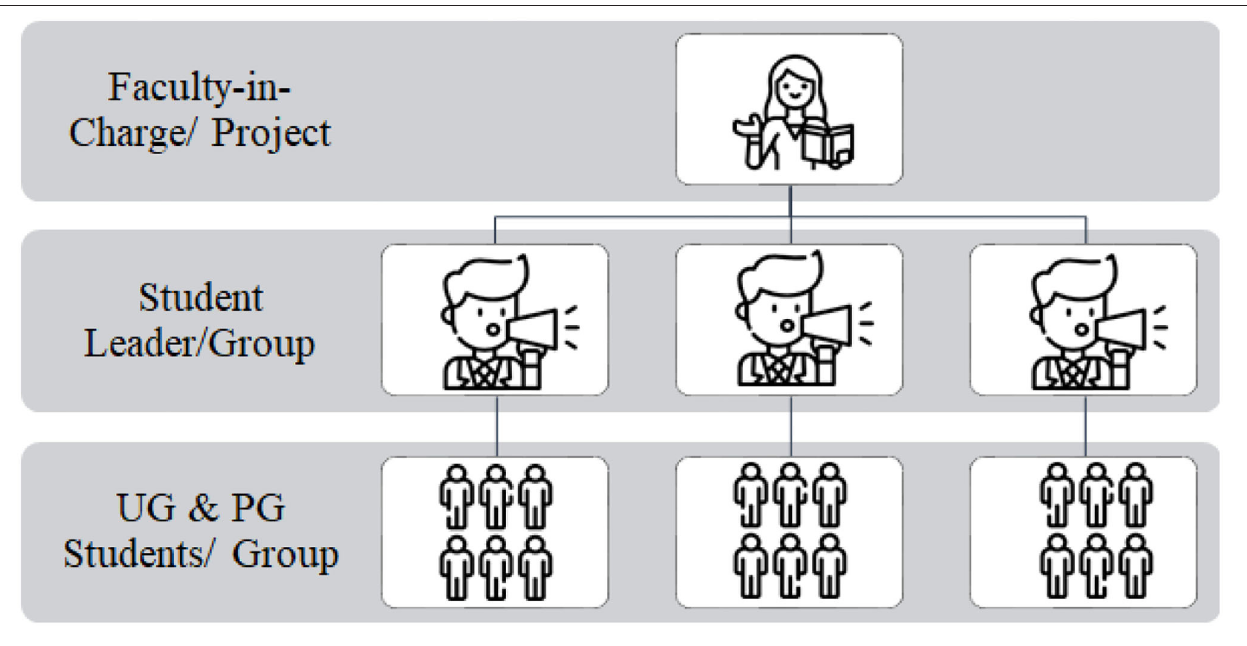
FIGURE 4 | Grouping of students for UWP